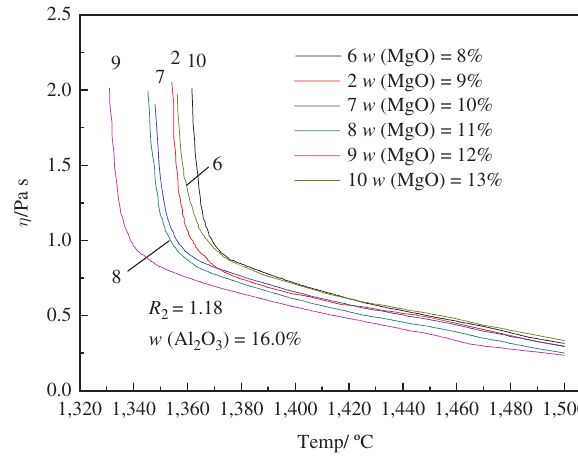
Figure 5: Effect of w (MgO) on viscosity of